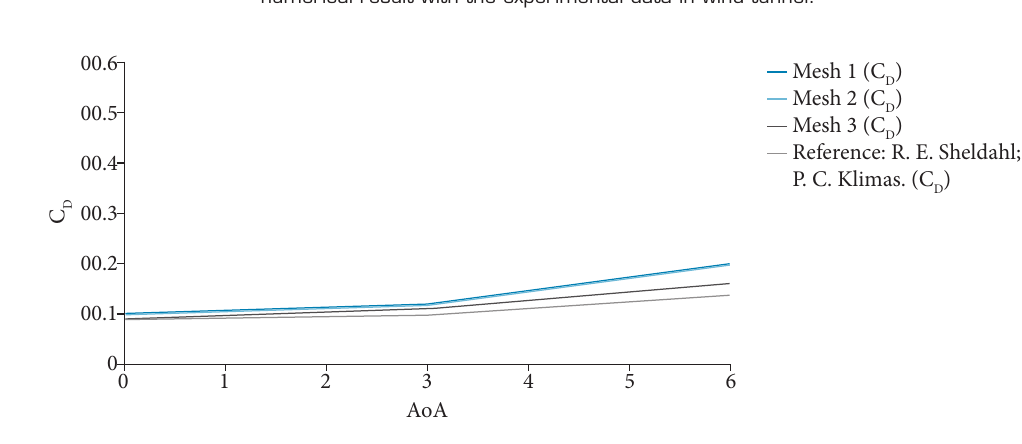
Figure 5. Drag coefficient (C ) as a function of the angle of attack comparing D numerical result with the experimental data in wind